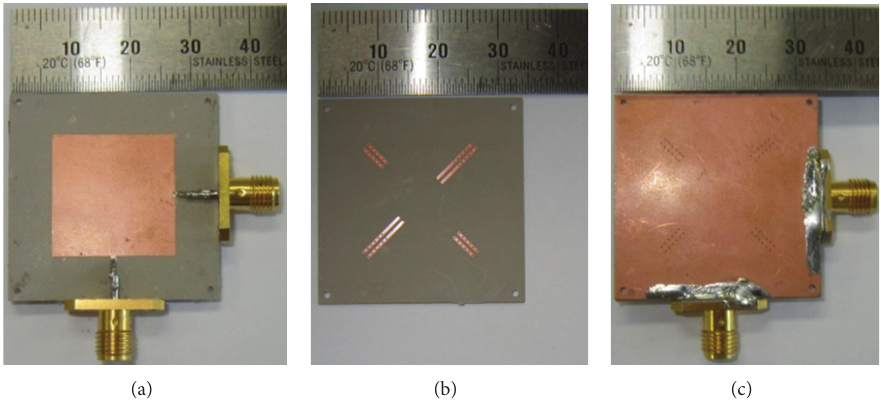
Figure 8: Fabricated prototype of the proposed filter: (a) top view, (b) top of substrate 1, (c) bottom